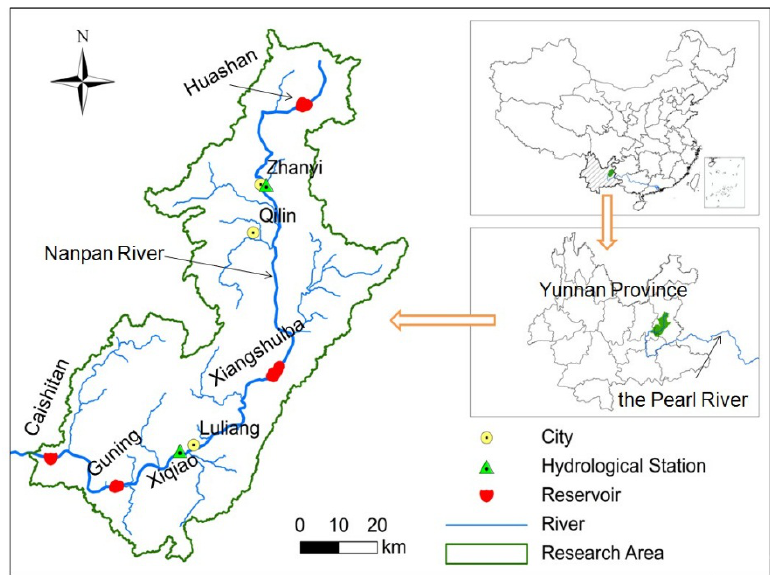
Figure 1. Location of the research